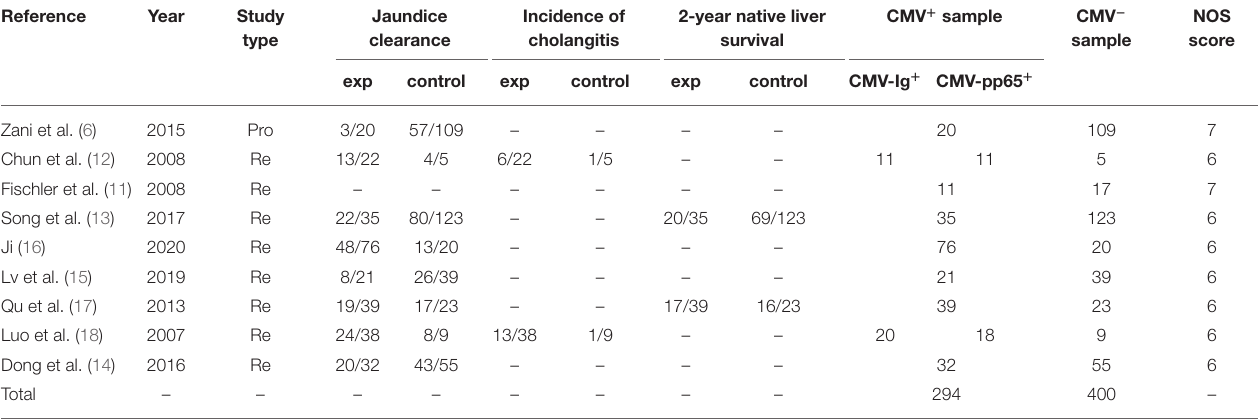
TABLE 1 | Characteristics of the reports included in the meta-analysis.